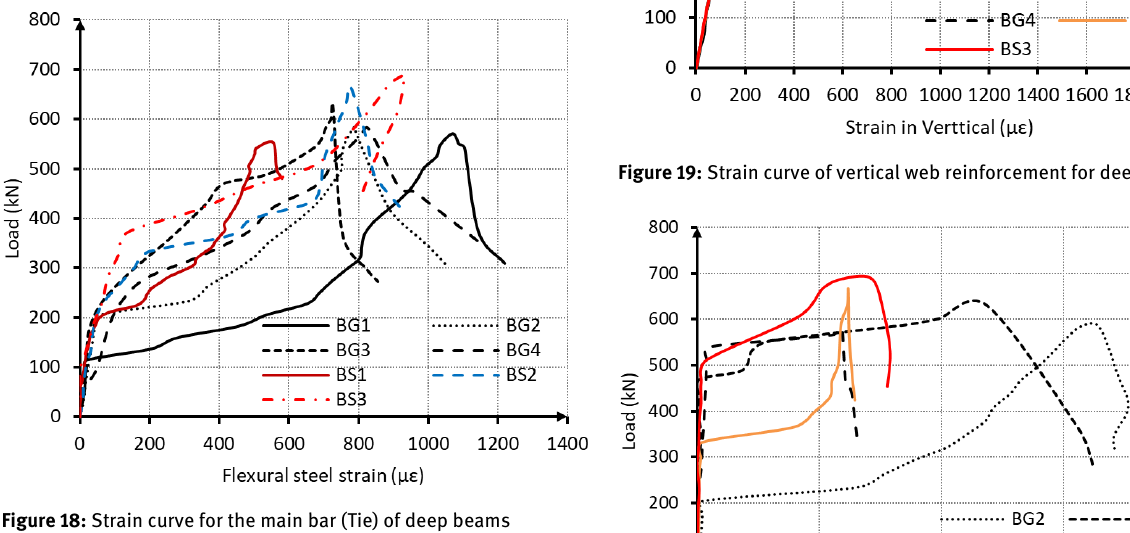
Figure 18: Strain curve for the main bar (Tie) of deep beams